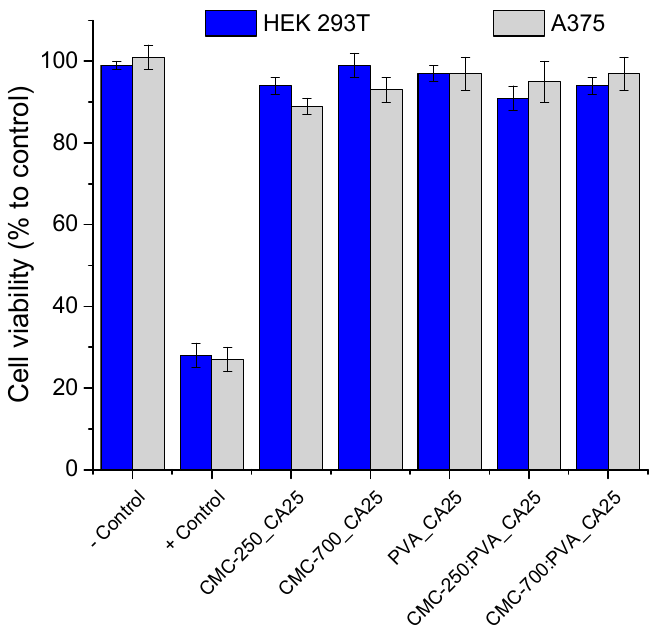
Figure 14. Cell viability results of HEK293T and A375 cell cultures based on MTT protocols after 24 h of incubation with hydrogels.